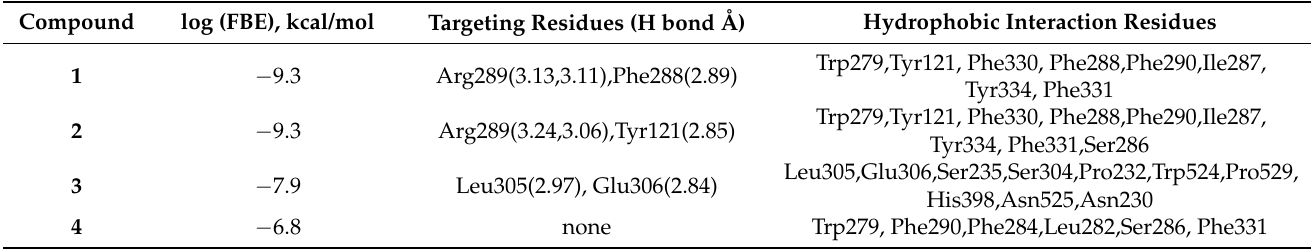
Figure 5. Docking model for compounds 1 − 4 with AChE (PDB ID: 1QTI). Hydrogen bonds and hy- drophobic interactions are indicated by green and red lines between the atoms involved, respectively. Table 2. Binding energies and targeting residues in the active pocket between compounds 1 − 4 and AChE (PDB ID: 1QTI).